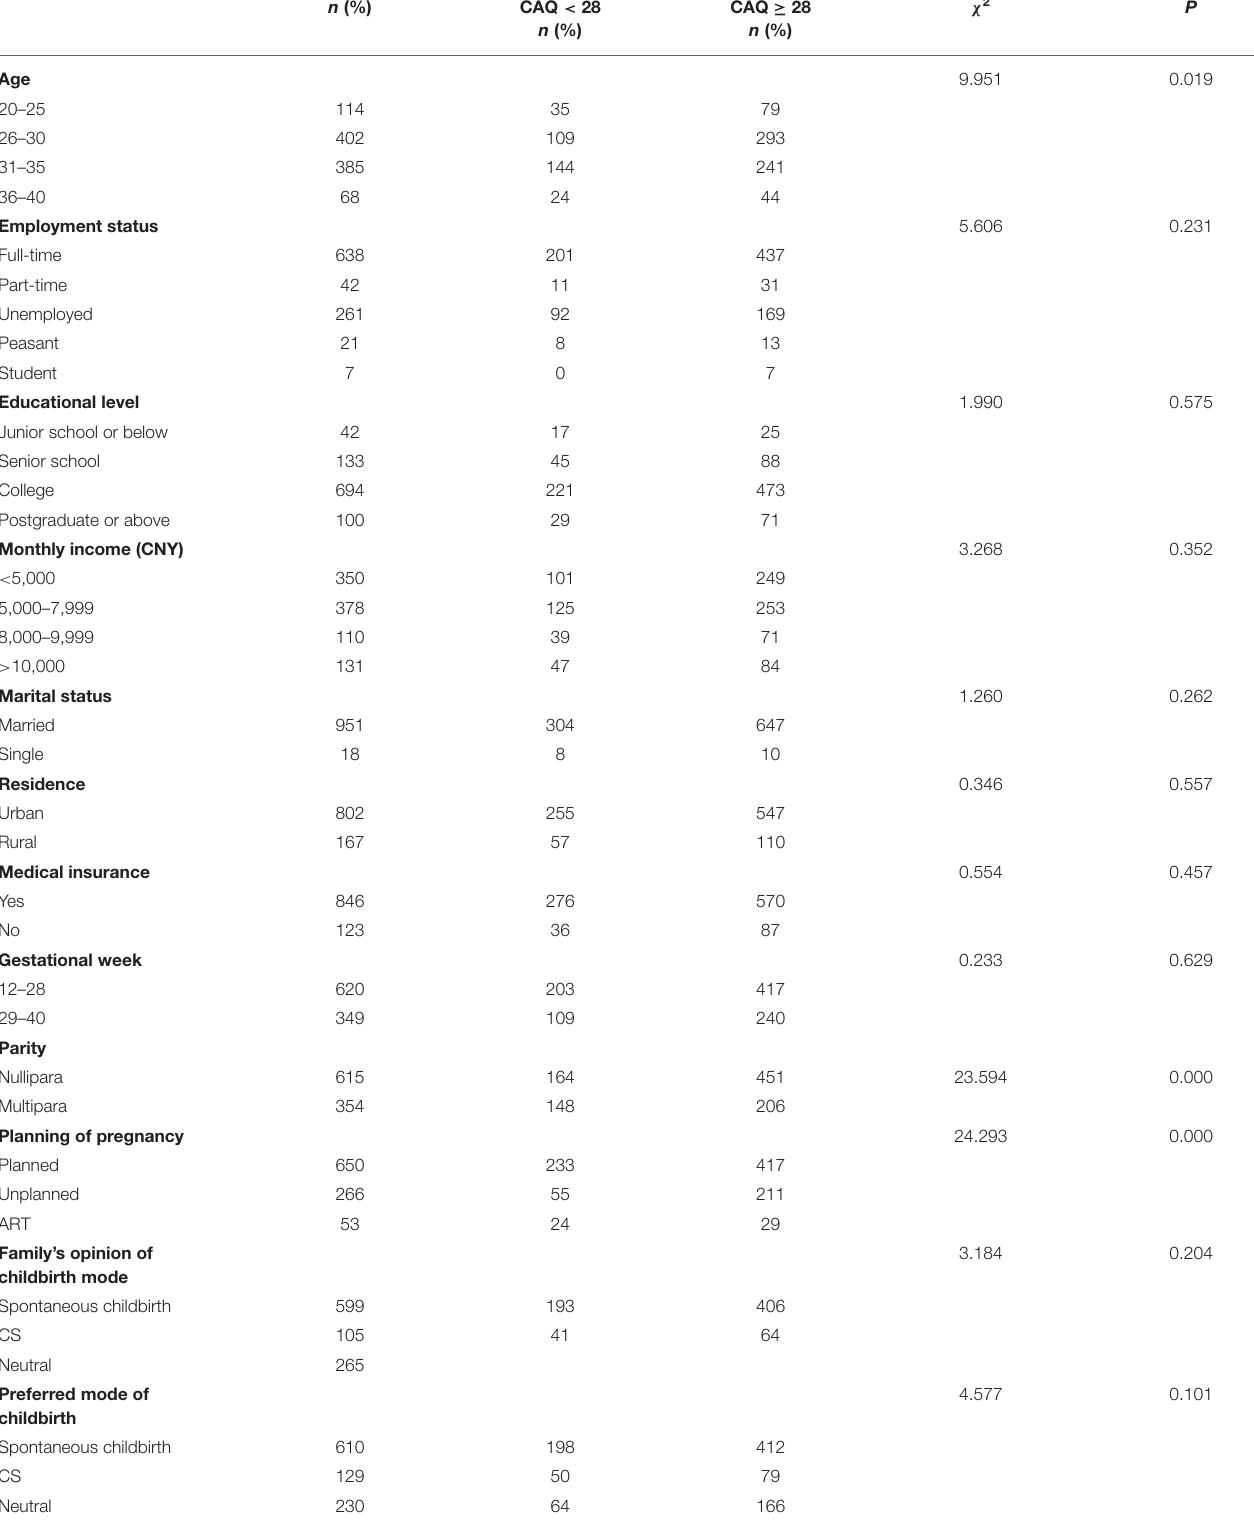
TABLE 1 | Sociodemographic characteristics of participants ( N =